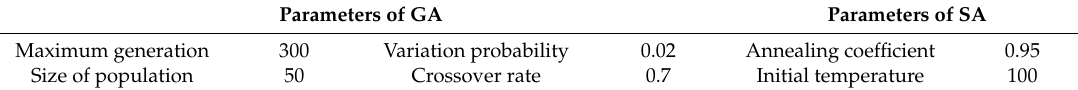
Table 1. Parameters of the Genetic Algorithm (GA) and the Simulated Annealing (SA).